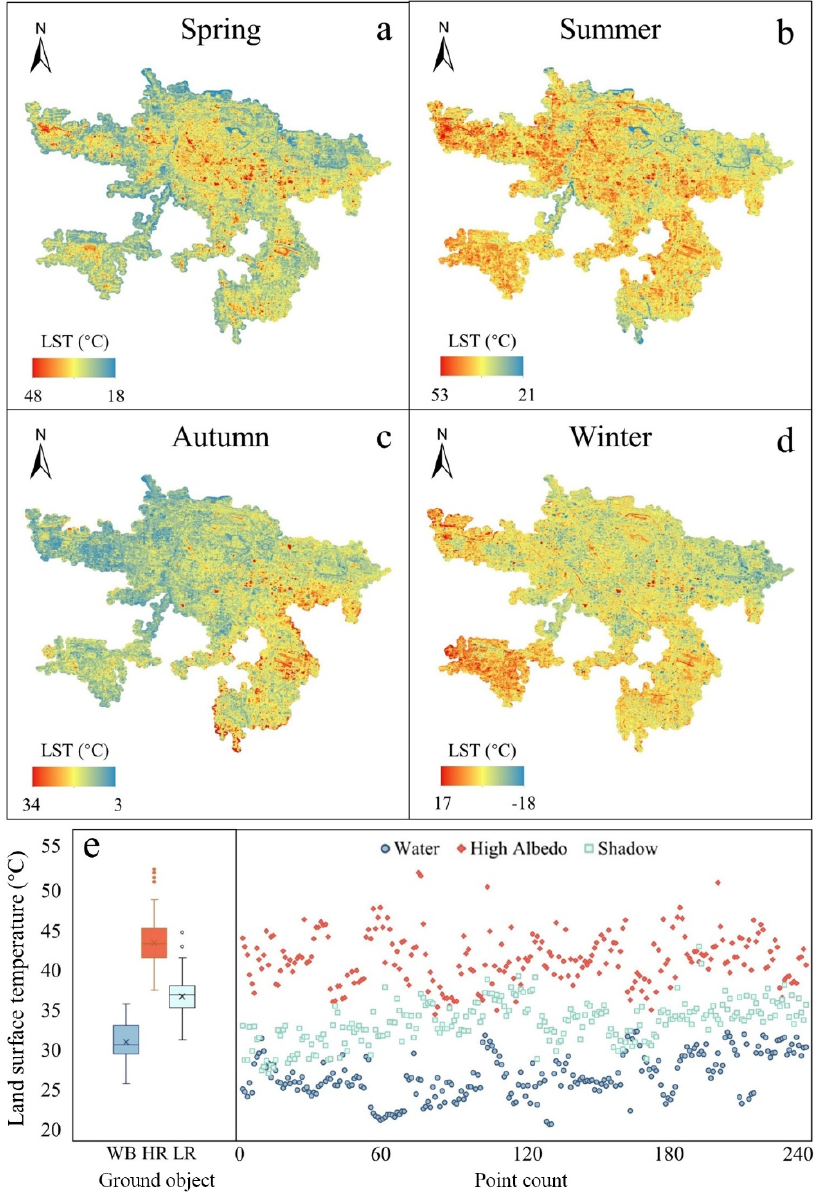
Figure 3. Land surface temperature (LST) inversion in different seasons: ( a ) spring, ( b ) summer, ( c ) autumn, and ( d ) winter, and ( e ) temperature differences of sample points of three urban coverage types: water bodies and low- and high-reflection objects. The abbreviations of WB, HR, and LR in the figure represent water bodies, high-reflectance, and low-reflectance ground objects, respectively. Table 2. Average LST of different objects in all four